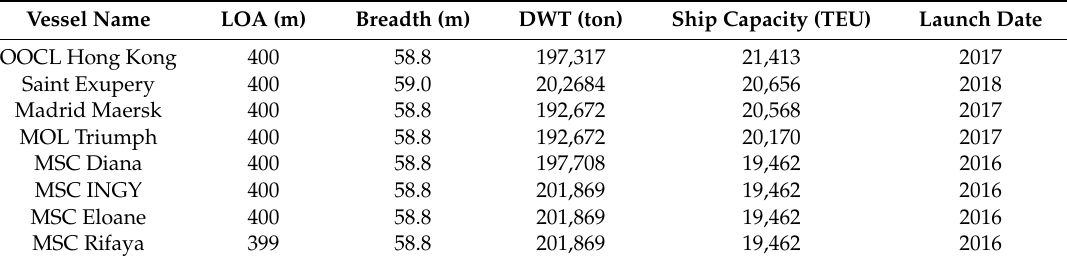
Table 1. The Dimension of Mega Vessels.